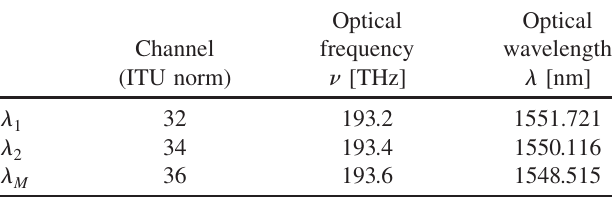
TABLE II. Optical carrier.